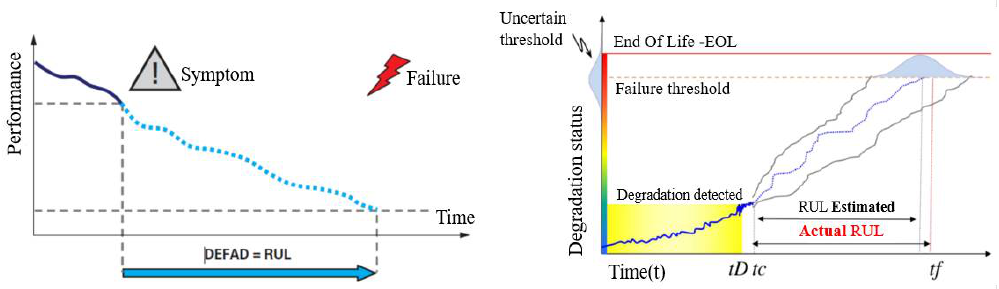
Figure 13. Representation of the residual life .